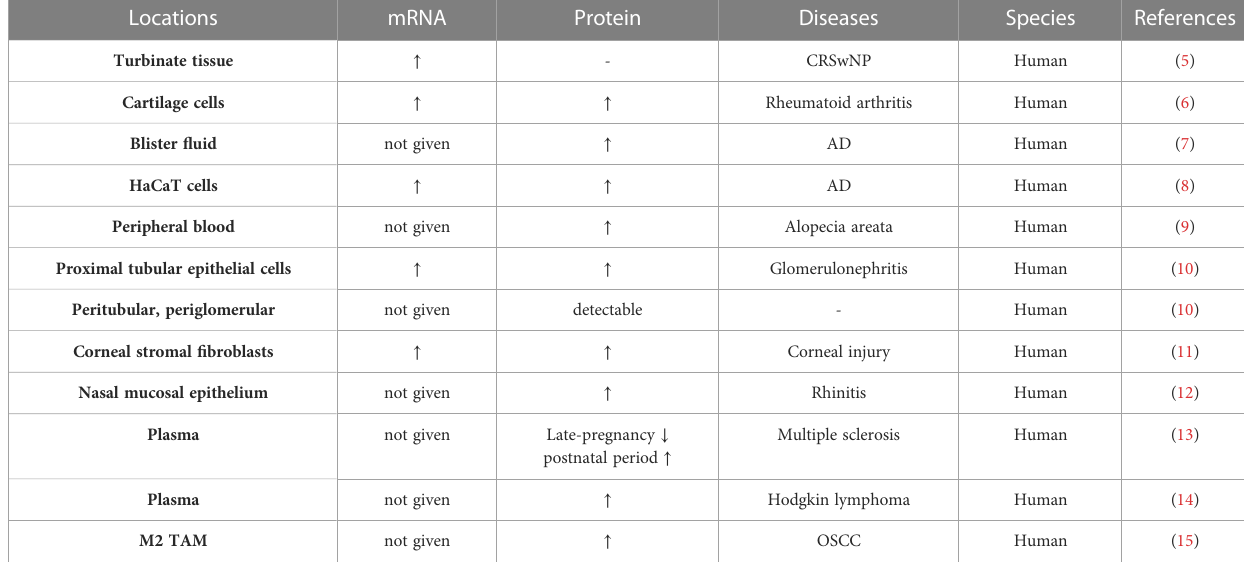
TABLE 1 Cells or tissues expressing CCL13 at the protein level in humans. Locations mRNA Protein Diseases